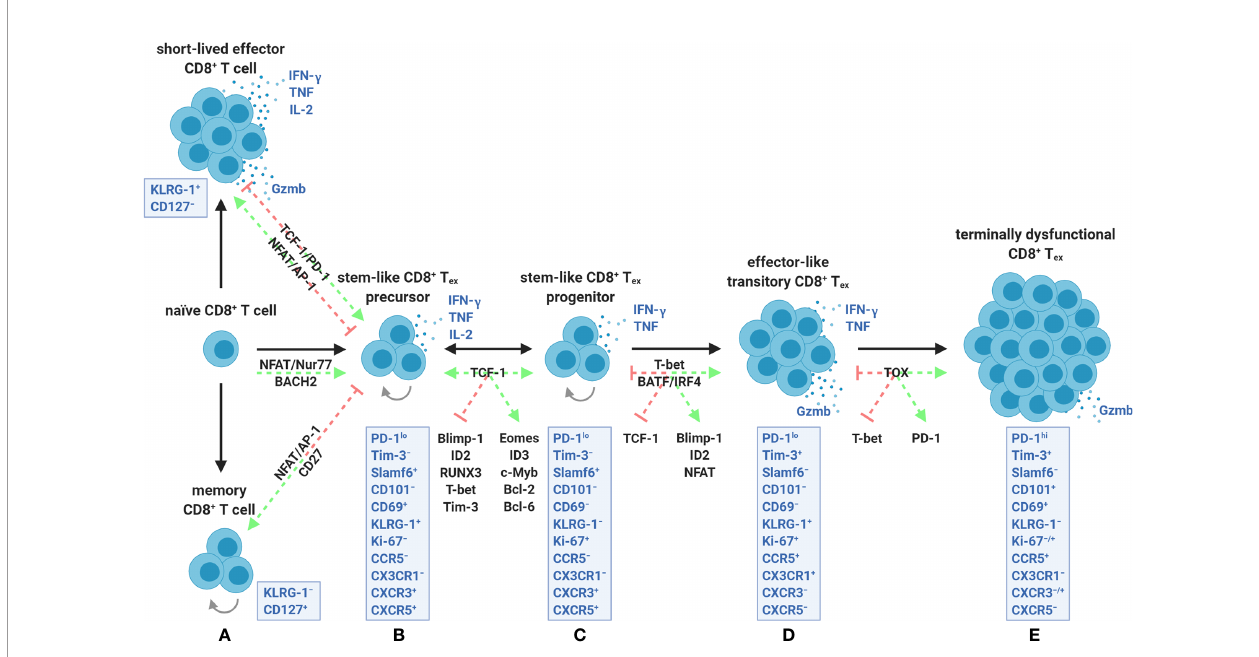
FIGURE 4 | The CD8 + T cell exhaustion lineage is comprised of a continuum of transcriptionally and epigenetically controlled states. (A) Activation of naïve CD8 + T cells for SLEC and MPEC/memory differentiation is optimally driven by transcription factors such as NFAT/AP-1 and suf fi cient co-stimulation ( e.g. , CD27). Early development of stem-like CD8 + T ex precursors instead involves partnerless NFAT, lack of co-stimulation/help, constant Nur77 activity, and/or strict dependence on BACH2. These events appear to be stabilized by TCF-1 activity and PD-1 dampening of chronic TCR ligation. (B, C) TCF-1 further supports stemness (ability to survive, self-renew, and proliferate) by promoting Eomes, ID3, c-Myb, Bcl-2, and Bcl-6 expression while antagonizing effector-associated transcription factors including Blimp-1, ID2, RUNX3, and T-bet. Stem-like CD8 + T ex precursors (B) and progenitors (C) are collectively marked by a PD-1 lo Tim-3 − Slamf6 + surface pro fi le and varied expression of CXCR3 and CXCR5 in speci fi c tumor settings. Although equally stabilized by TCF-1, precursors can be distinguished from progenitors as being quiescent, LN-resident, less reliant on antigen, and having a CD69 + KLRG-1 + Ki-67 − pro fi le. (C, D) TCF-1 down-regulation coupled with ongoing exposure to persistent antigen drives constant BATF and IRF4 signaling (which positively feedback on partnerless NFAT activity) and T-bet expression. T-bet additionally overrides a TCF-1 memory-like program by supporting Blimp-1 and ID2 activity leading to an effector-like transitory PD-1 lo Tim-3 + state marked by initiation of granzyme B production. (D, E) Continued NFAT activity ultimately leads to TOX upregulation within this subpopulation, which epigenetically enforces terminal exhaustion, inhibits T-bet-mediated effector programming, and promotes heightened PD-1 expression. Transitory cells (D) are discriminated from terminally dysfunctional cells (E) by a PD-1 lo Tim-3 + CD101 − KLRG-1 + CX3CR1 + surface phenotype, remnant IFN- g and TNF production, and having high proliferative potential. Terminally dysfunctional PD-1 hi Tim-3 + CD8 + T ex co-express multiple co-inhibitory receptors (not depicted), cannot proliferate, have diminished polyfunctionality, but retain granzyme-based cytolytic potential. PD-1 lo precursors, progenitors, and transitory CD8 + T ex subpopulations are amenable to ICB (B – D) , whereas terminally dysfunctional PD-1 hi CD8 + T ex are not (E) . Precursors and progenitors may interconvert, whereas differentiation into transitory and terminally dysfunctional subsets is